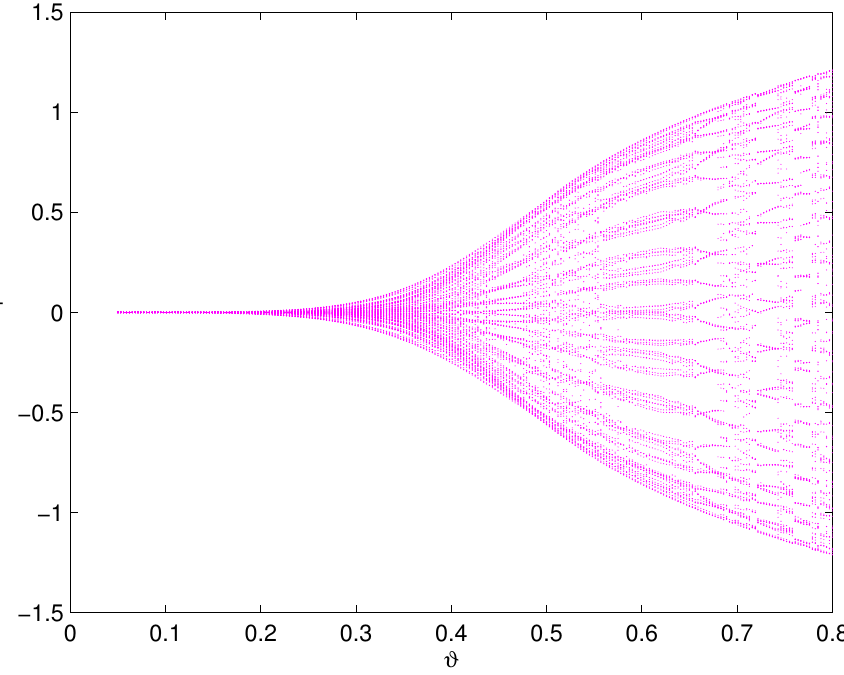
Figure 10. Bifurcation graph of system (72): the time delay ϑ versus the variable w 1 . The bifurcation number is